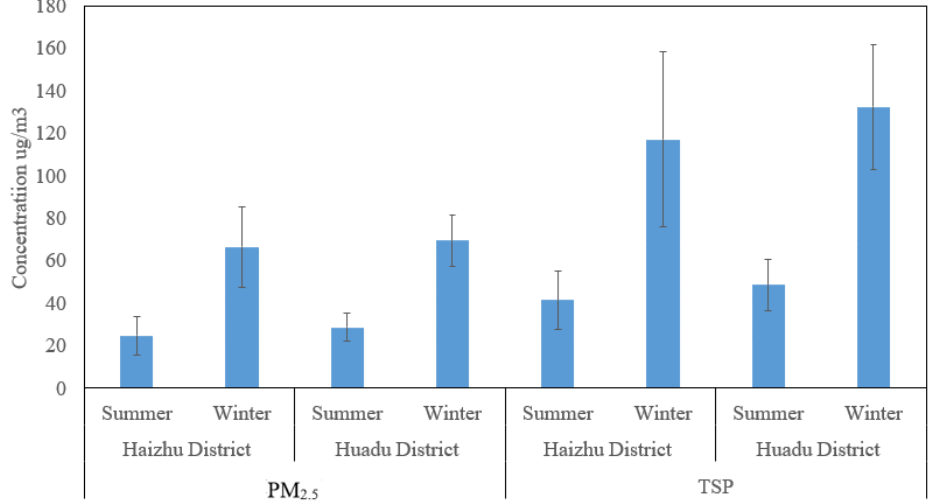
Figure 1. The mass concentrations of PM 2.5 and TSP outdoors in 2019. The temporal and spatial variations in nitro-PAH concentrations in PM 2.5 and TSP in Guangzhou are shown in Tables 1 and 2. In the summer of 2019, the average nitro-PAH concentrations outdoors and indoors in PM 2.5 in Haizhu District were 0.116 ± 0.0125 and 0.0855 ± 0.0321 ng/m 3 , respectively, and nitro-PAHs in TSP were 1.11 ± 0.242 and 0.797 ± 0.173 ng/m 3 . In the winter of 2019, the average nitro-PAH concentrations in PM 2.5 in Haizhu District were 0.195 ± 0.0176 (outdoors) and 0.152 ± 0.0230 (indoors) ng/m 3 , and nitro-PAHs in TSP were 1.34 ± 0.202 and 0.996 ± 0.0643 ng/m 3 , respectively. In the summer of 2019, the average nitro-PAH concentrations outdoors and indoors in PM 2.5 in Huadu District were 0.447 ± 0.267 and 0.169 ± 0.0290 ng/m 3 , respectively, and nitro-PAHs in TSP were 0.892 ± 0.130 and 0.642 ± 0.225 ng/m 3 . In winter 2019, the average nitro-PAH concentrations in PM 2.5 in Huadu District were 0.235 ± 0.0245 and 0.177 ± 0.0341 ng/m 3 , respectively, and the nitro-PAHs in TSP were 0.712 ± 0.192 and 0.462 ± 0.0837 ng/m 3 . There were differences between the average concentrations of nitro-PAHs in PM 2.5 and TSP from different districts of Guangzhou but the differences were not statistically significant ( p > 0.05). Owing to the low latitude, the surface of Guangzhou receives more solar radiation. Meanwhile, it is affected by the monsoons, the climate features high temperatures, high humidity, and much rain in summer, while in winter, the climate features low temperatures, dryness, and little rain. In the Haizhu District and Huadu District, there was no decrease in the average nitro-PAH concentrations in PM 2.5 and TSP from dry winter to wet summer. The small direct emission of nitro-PAHs in summer and photochemical reactions may be important causes of this pattern. The urban air pollution in Guangzhou in summer is mainly O 3 and NOx pollution [37,38], which leads to the secondary formation of various nitro-PAHs when exposed to free radicals. In nitro-PAHs, the formation of 1-NP is most significant when exposed to NO 3 /N 2 O 5 and · OH radicals, while 9-NT can be formed when exposed to NO 3 /N 2 O 5 radicals. Therefore, the concentration levels of nitro-PAHs in PM 2.5 and TSP do not significantly decrease in the wet summer, which may be related to the formation of photochemical reactions with exposure to free radicals.